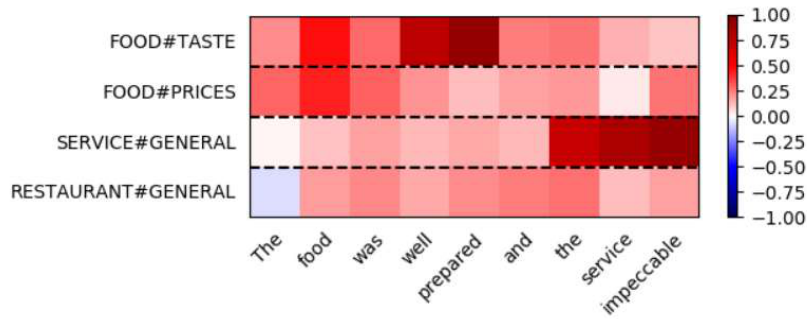
Figure 4. Final representation visualization. Each row represents the relationships between the corresponding aspect and the sentence. The darker color means the greater correlation of the sentence and the aspect.